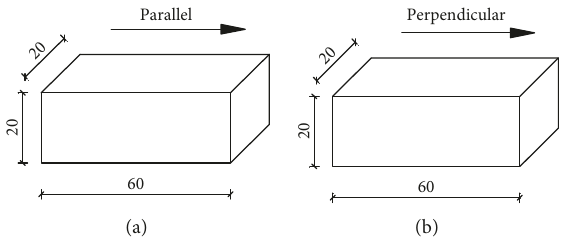
Figure 3: Compression specimen. (a) Parallel to grain. (b) Perpendicular to grain.